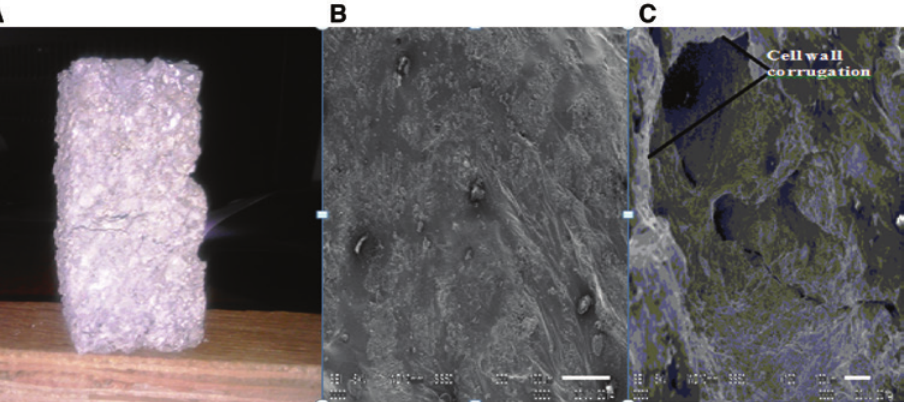
Figure 3: Foam-2 (A) Cross-sectional image (B) SEM image of distribution of Zn particles in inner cell wall (C) cell wall